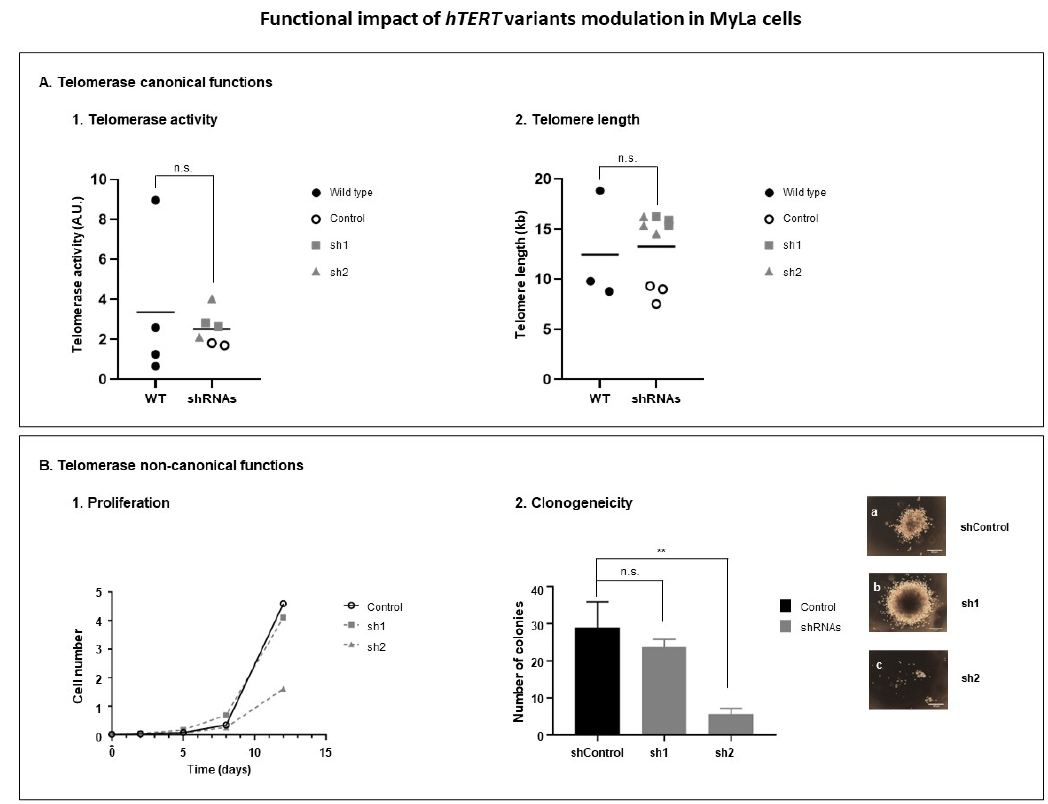
Figure 5. Functional impact of hTERT variants modulation in MyLa cells. After one month of transduction with shRNAs, in MyLa cells, ( A ) telomerase canonical functions were evaluated through the assessment of ( A1 ) telomerase activity and ( A2 ) telomere length. In the same transduced cells, ( B ) telomerase non-canonical functions were evaluated, through the assessment of ( B1 ) cell proliferation and ( B2 ) cell colony formation capacities. Figures ( a – c ), show colony images of MyLa control cells as well as transduced MyLa cells with sh1 and sh2, respectively. A.U.: arbitrary unit;